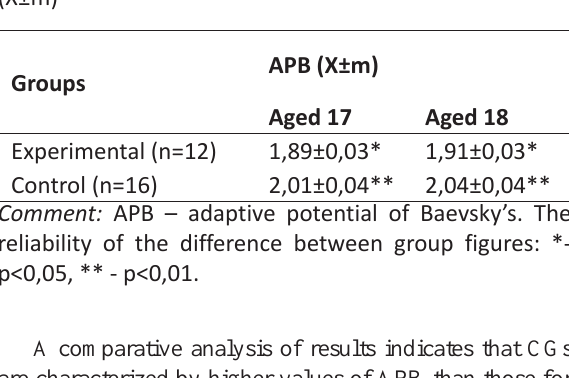
Table 1. Average statistical figures and evaluation